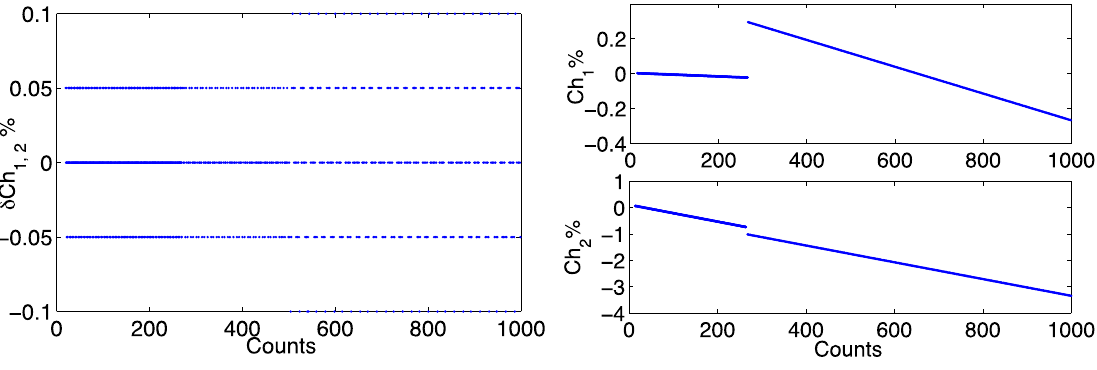
Figure A3. We show, ( left ) the lower and higher bounds for the differences between ideal dual- and single-gain implementation in both channels and, ( right ) the differences between the simulated NOAA-14 and NOAA-18 single-gain counts. In the ideal case, the lower and higher bounds of the difference are −0.05% and 0.05% respectively ( left ). The difference between the simulated NOAA-14 and NOAA-18 single-gain counts are 4 times higher than ideal in channel-1 and 40 times higher in channel-2. Notice the change of slope from the low to the high gain counts in the differences between single- and double-gain in channel-1 signaling difficulties on calibration when identical instrument degradation for both low and high gain modes is